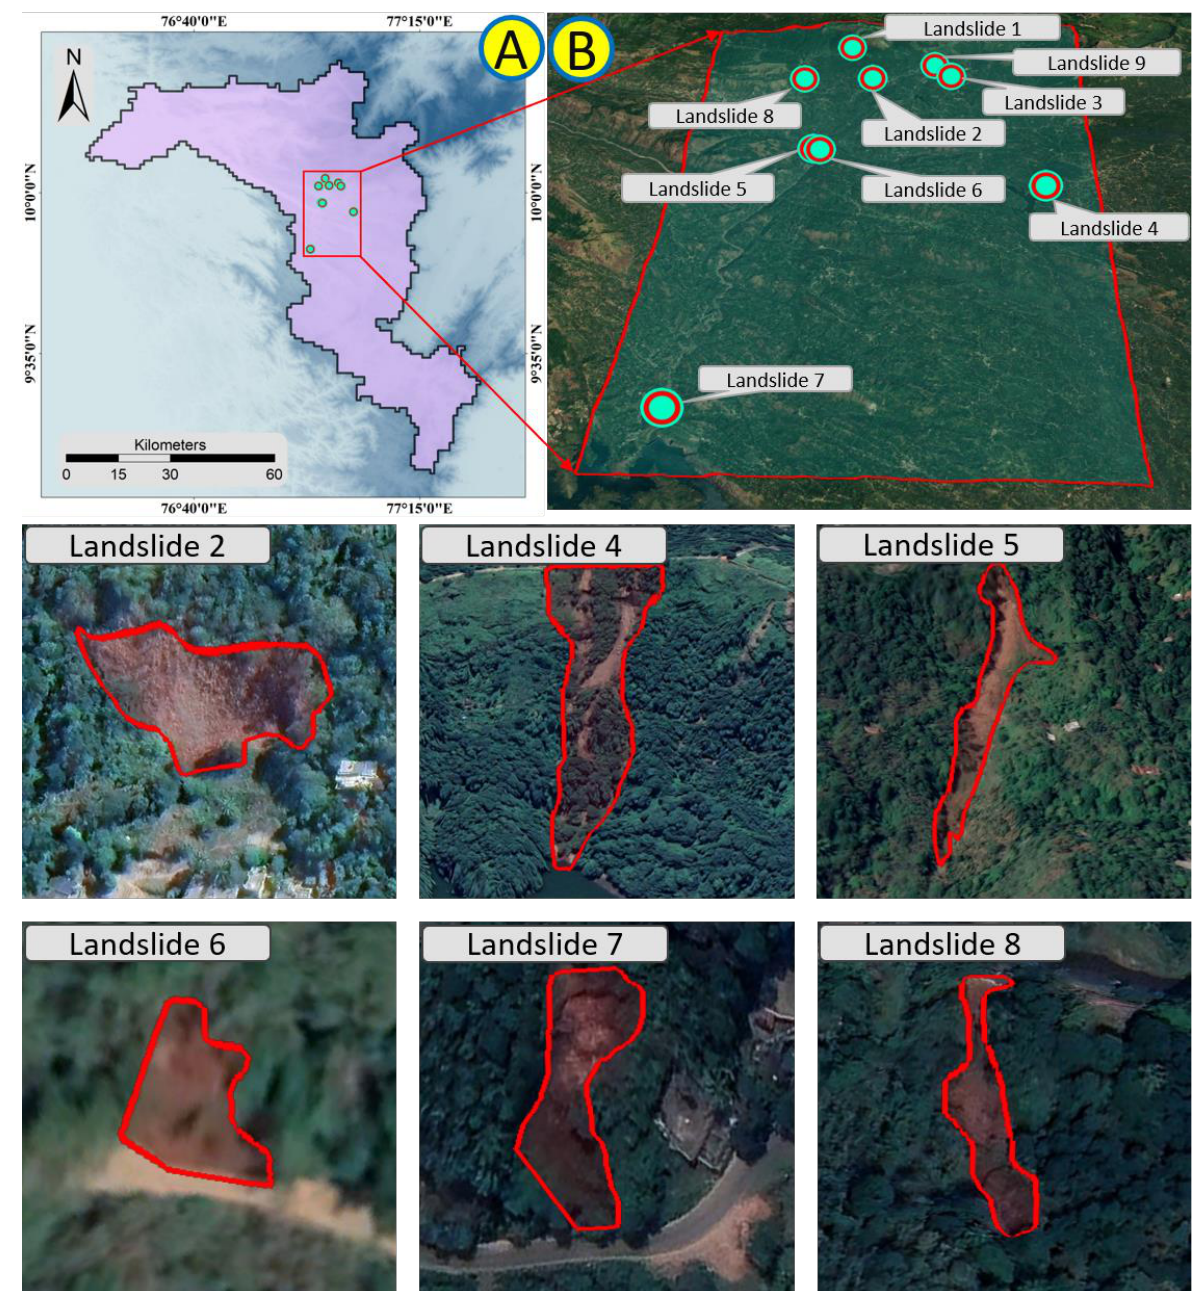
Figure 3. Locations of the 9 events selected for finding the timing of initiation through computing FoS as part of the study in the catchment area. ( A ) Geographical location of the landslide locations. ( B ) Landslide 1 to 9 in Google Earth images. Approximate shapes of Landslides 2, 4, 5, 6, 7, and 8 were available on Google Earth and given as six tiles.